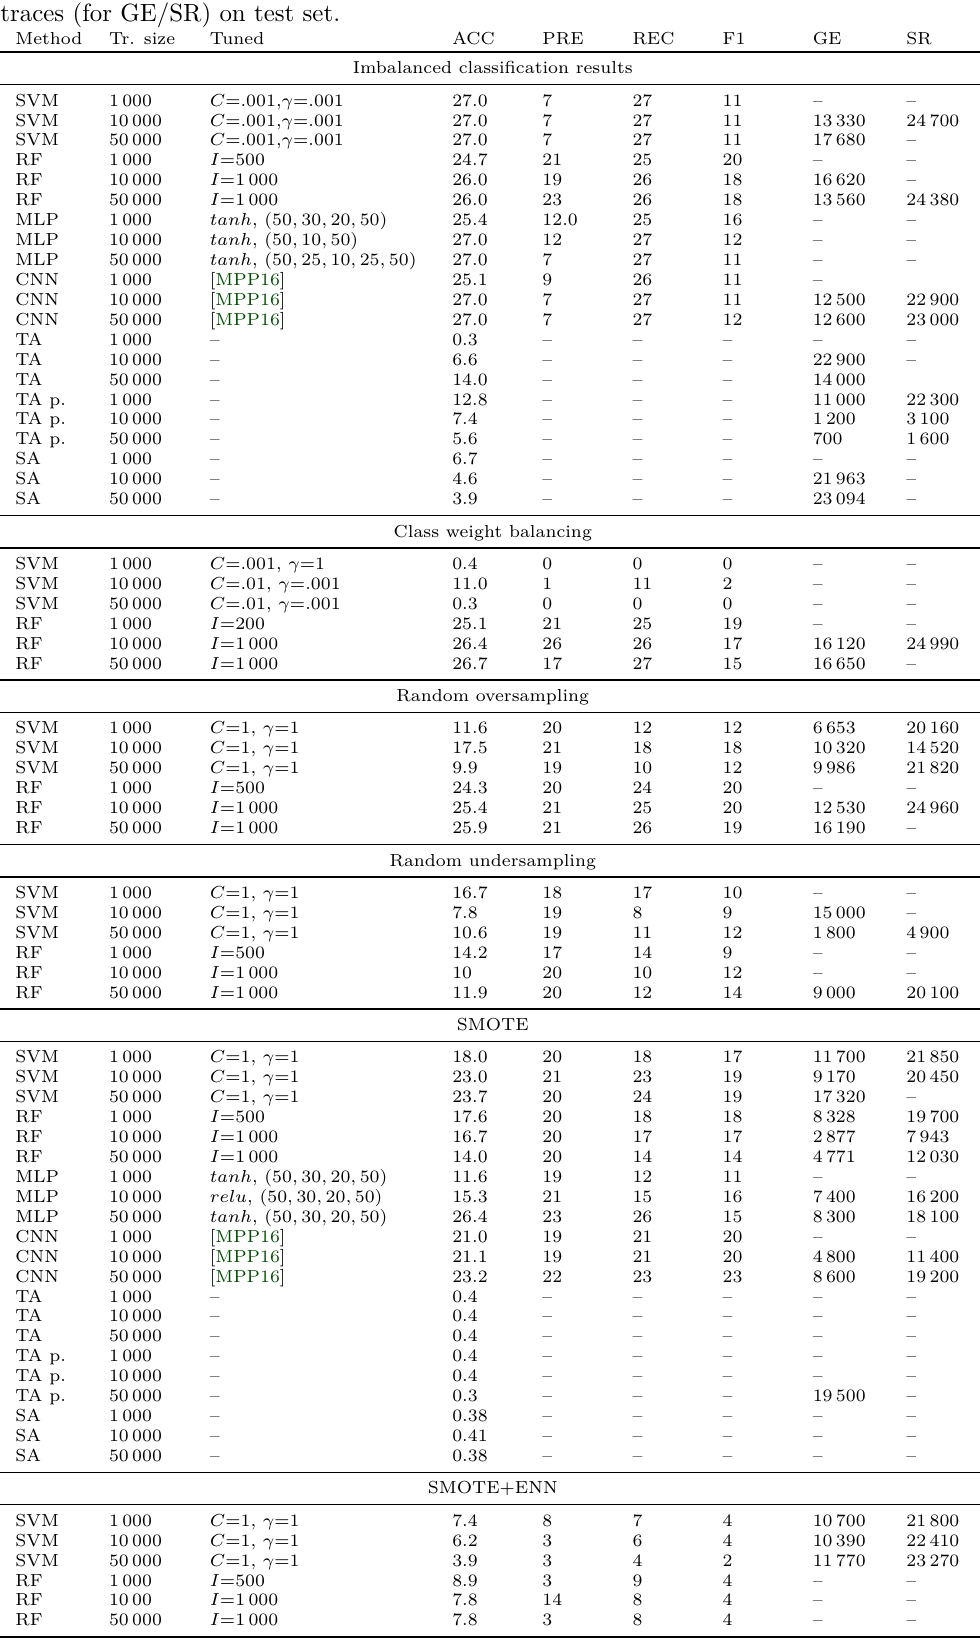
Table 7: AES_HD dataset. Values are given as percentages (ML metrics) and number of traces (for GE/SR) on test